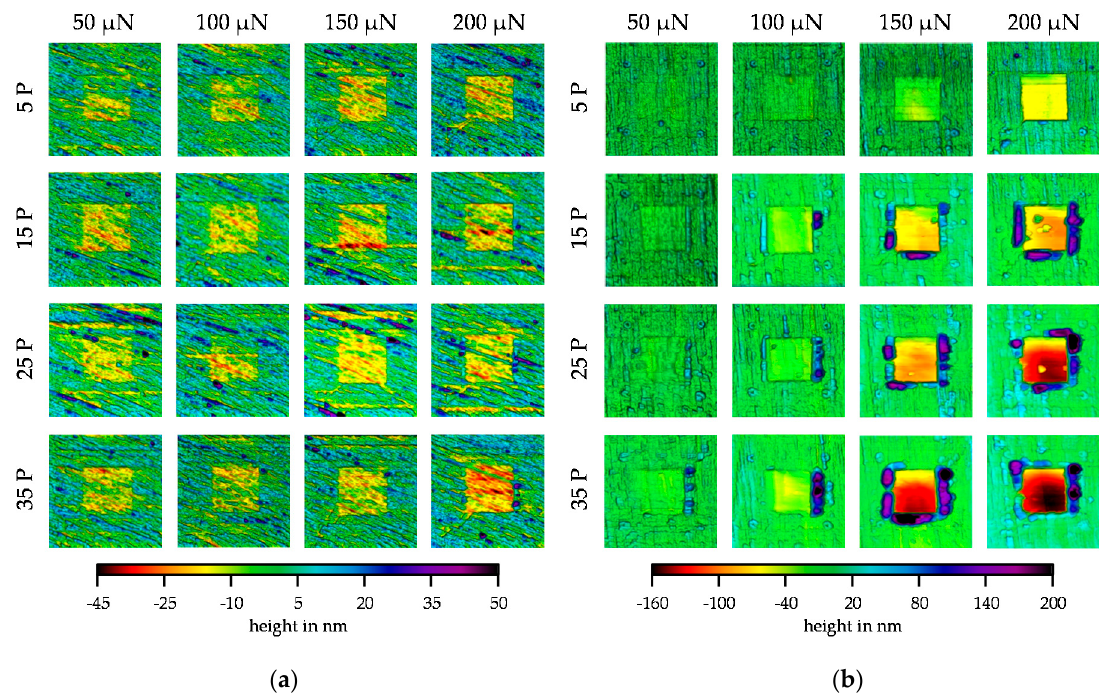
Figure 11. Evolution of the wear fields over the normal forces ( μ N) and number of passes (P) investigated: ( a ) Mo ‐ coating; ( b ) MoO 3 ‐ coating.